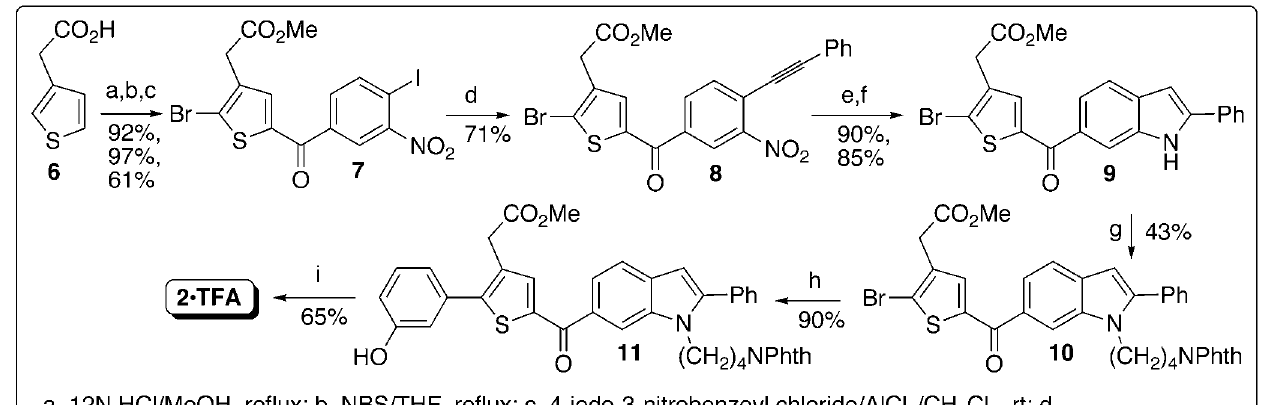
Figure 4. Synthetic scheme for inhibitor 2.